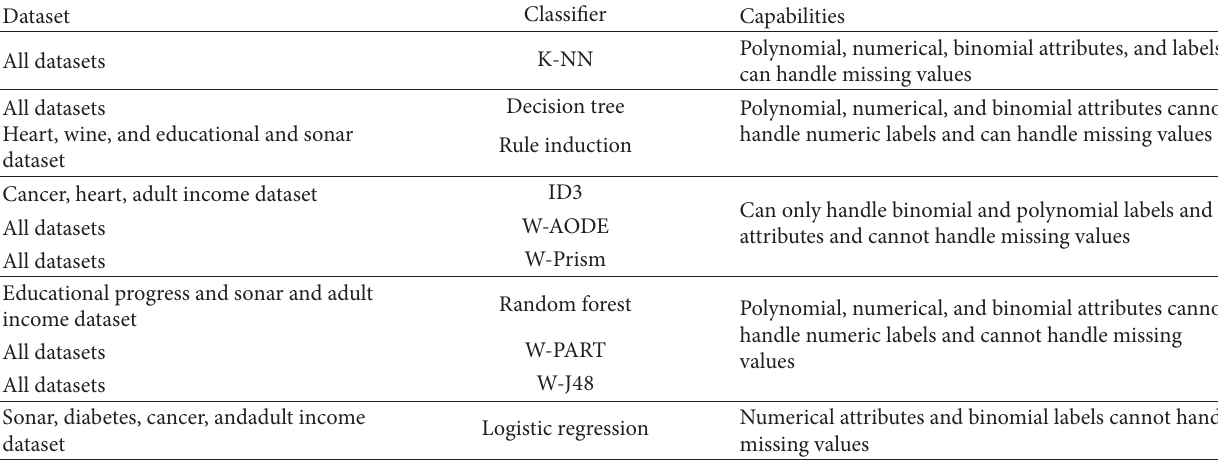
Table 5: Data set and suitable classifiers.